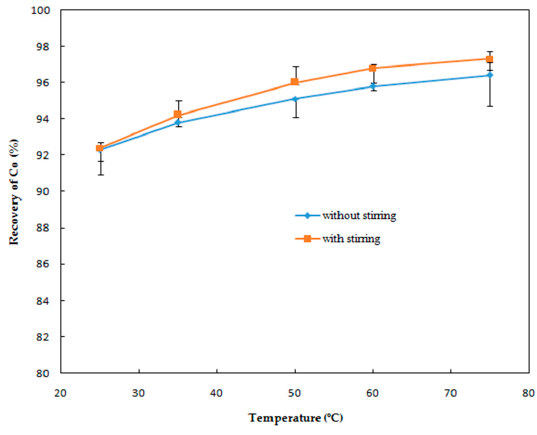
Figure 8. Effect of temperature on the recovery of Co.